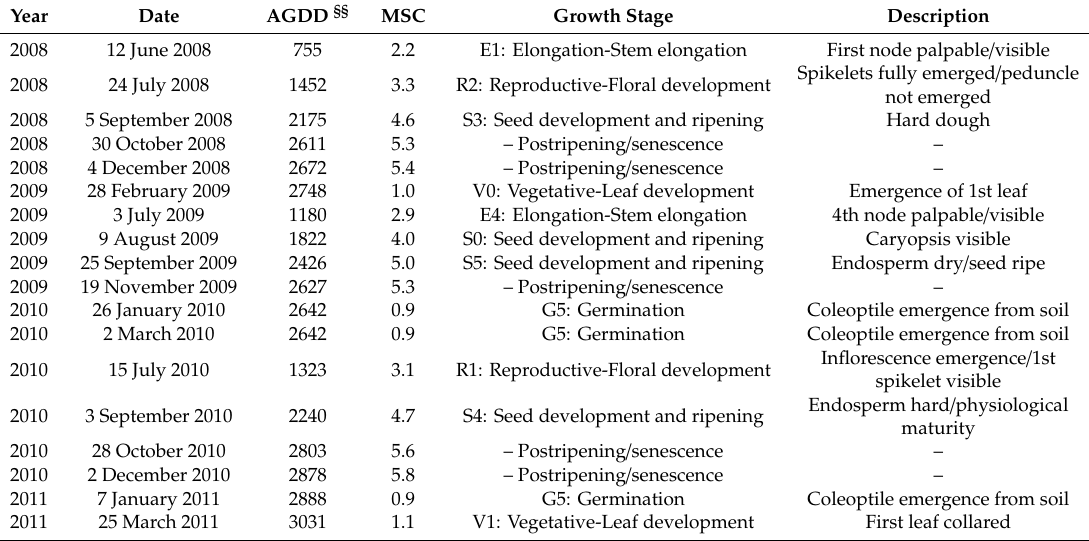
Table 2. Dates of periodic whole plant biomass harvests from and the accumulated growing degree days (AGDD) according to the Julian Day of the Year